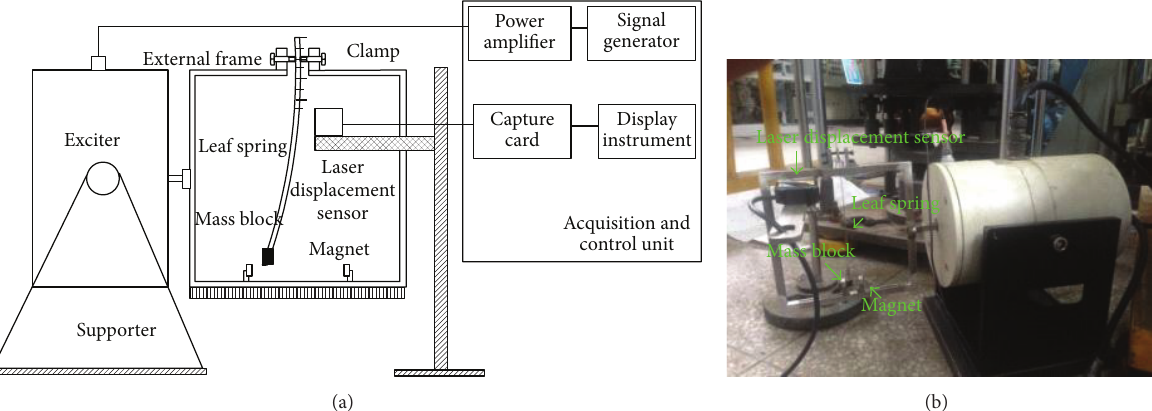
Figure 12: Two-well potential magnetic leaf spring chaotic vibration experimental rig. (a) Sketch of the experimental rig. (b) Photo of the experimental